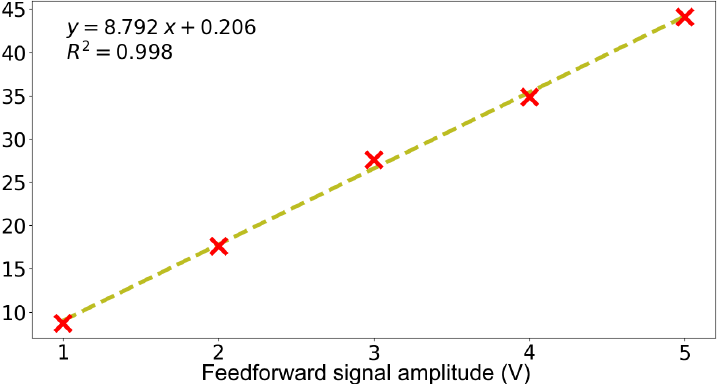
Figure 10. Relation between system voltage drop and feedforward signal amplitude for Cloud 2.